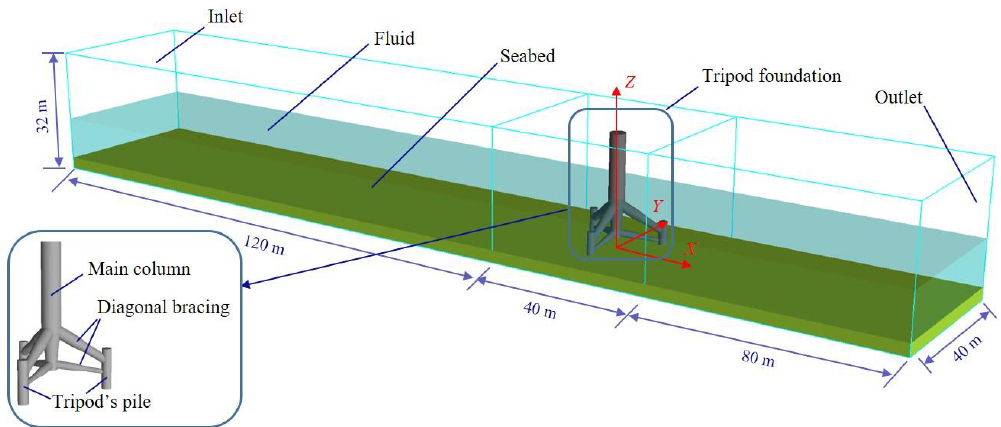
Figure 1. A sketch of the seabed-tripod-fluid numerical model.